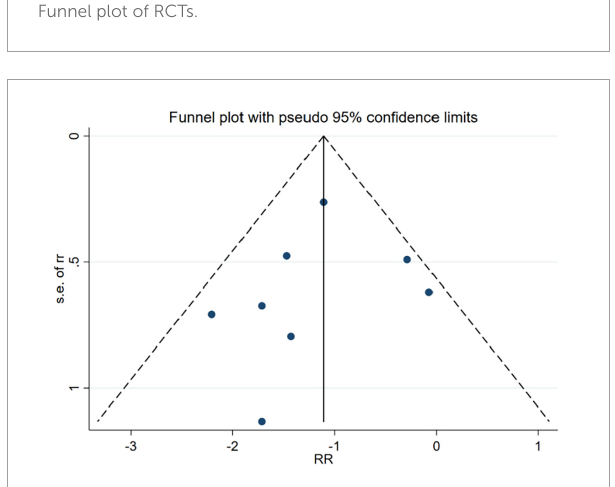
FIGURE10 Funnel plot of RCTs.